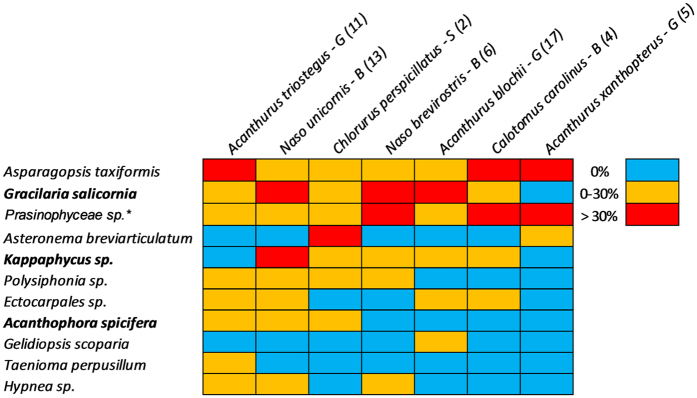
Heat map showing relative proportion of algae species found in herbivore gastrointestinal samples which accounted for at least 5% of identifiable gut contents for any fish species.Sample size (N) for each species provided in parentheses. Values are based on proportion of total OTUs for each herbivore species sampled: absent (0%), present (0–30%), and common (>30%). Each fish species is further identified by herbivore functional group: scraper (S), grazer (G), and browser (B). Invasive algae species are shown in bold. All algal species are macroalgae with the exception of Prasinophyceae spp. which is a class of unicellular green algae.